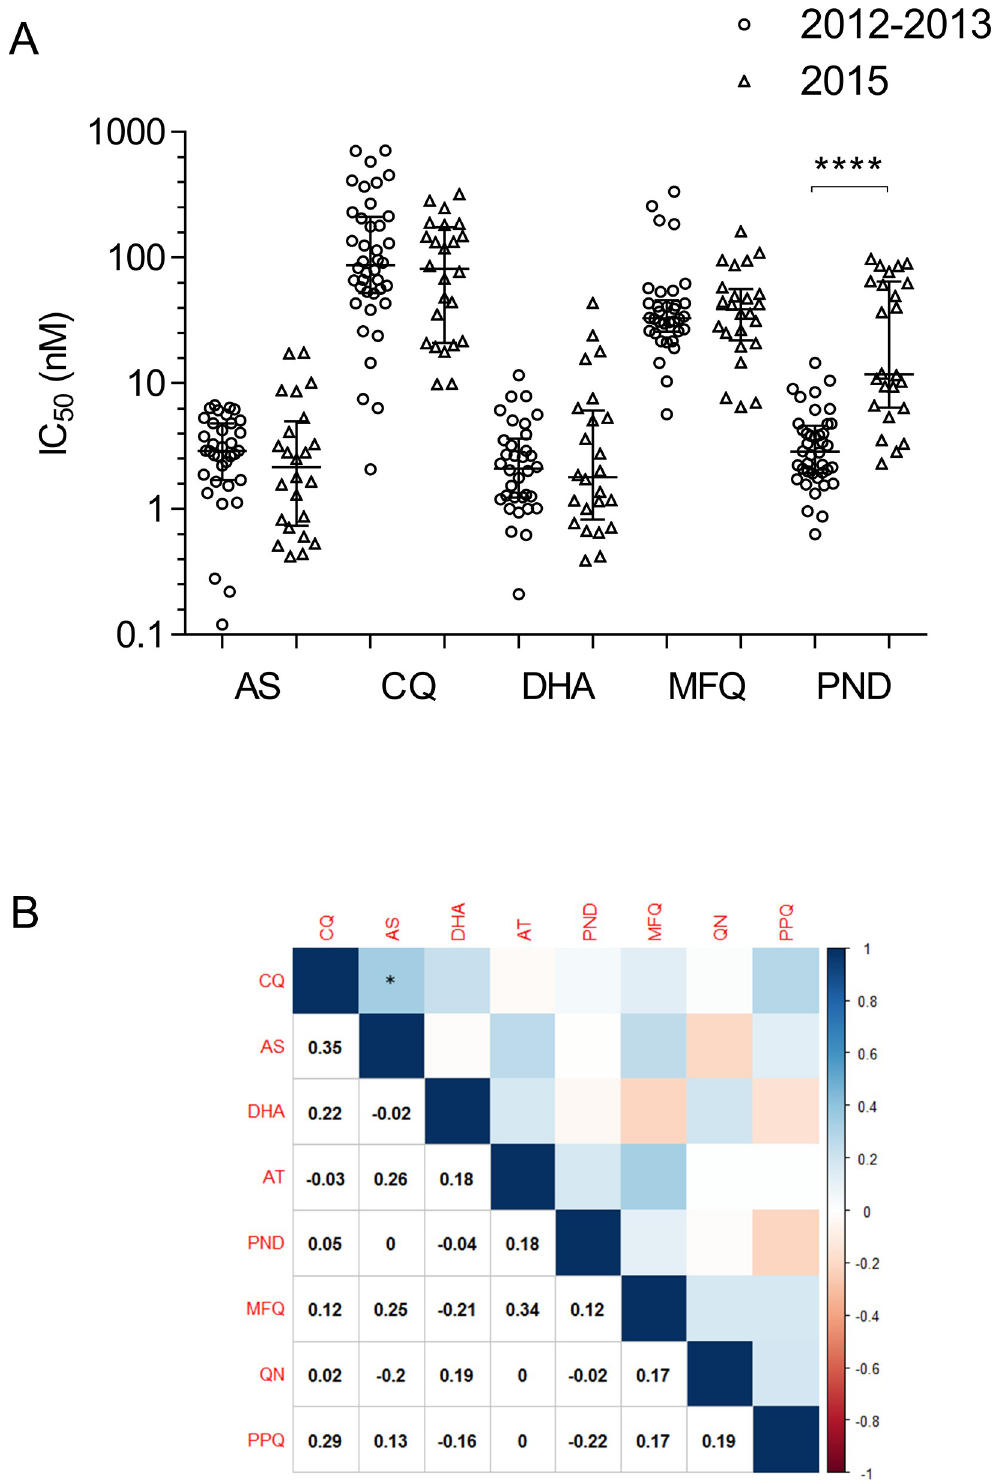
Fig 1. IC 50 values of P . vivax isolates for each antimalarial drug. A. Comparison of ex vivo IC 50 values (in nM) to five antimalarial drugs between parasite isolates collected in 2012–2013 and 2015. ���� indicates P < 0.0001 (Mann-Whitney U test). B. Spearman’s correlation analysis between IC 50 values of parasite isolates to eight antimalarial drugs. The values of the correlation coefficient were colored based on color scale shown on the right. � indicates significant